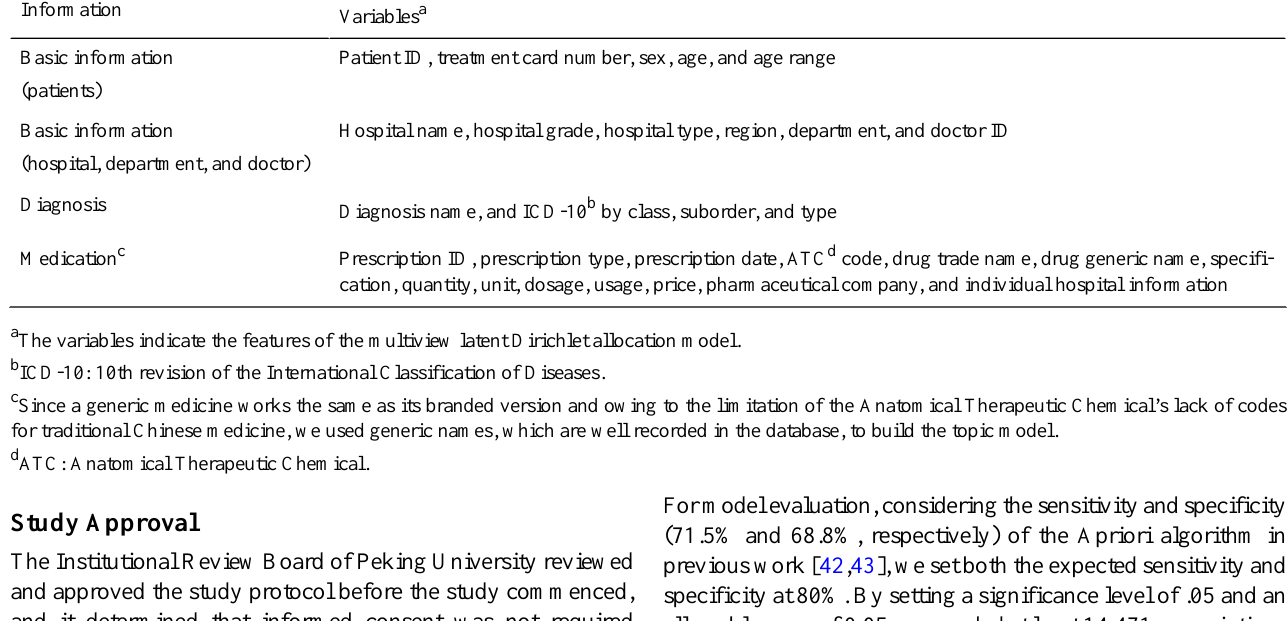
Table 1. Main variables in the Chinese Monitoring Network for the Rational Use of Drugs outpatient prescription monitoring subsystem. Variables a